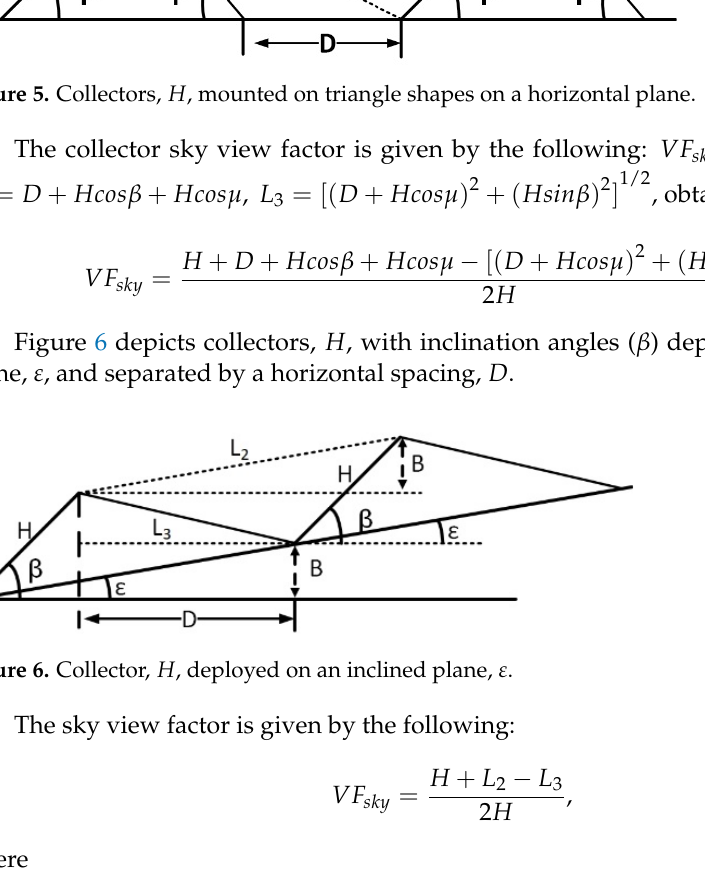
Figure 5. Collectors, H , mounted on triangle shapes on a horizontal plane.